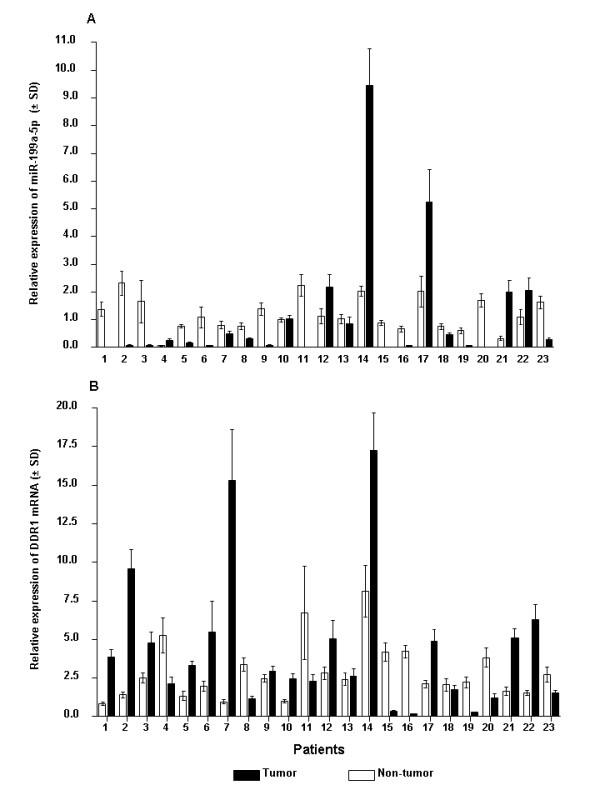
Expression of miR-199a-5p and DDR1 in HCC specimens. qRT-PCR analysis was performed using 23 paired surgical specimens of HCC tissues and adjacent normal tissues for miR-199a-5p (A) and DDR1 (B). Expression levels normalized to expression of reference genes, RNU44 and HMBS (A) and HMBS and GAPDH (B), are shown. Quantitative values representing the mean and SD from experiments performed in triplicate are presented.